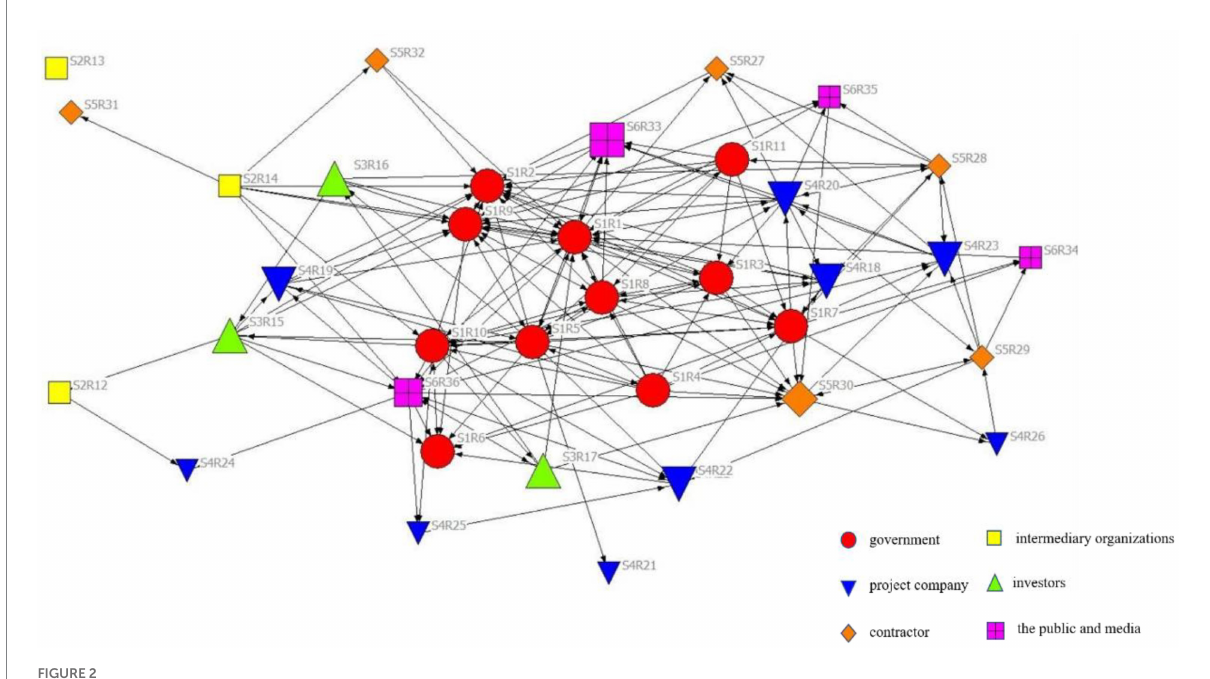
FIGURE 2 Stakeholder-related risk factor network.